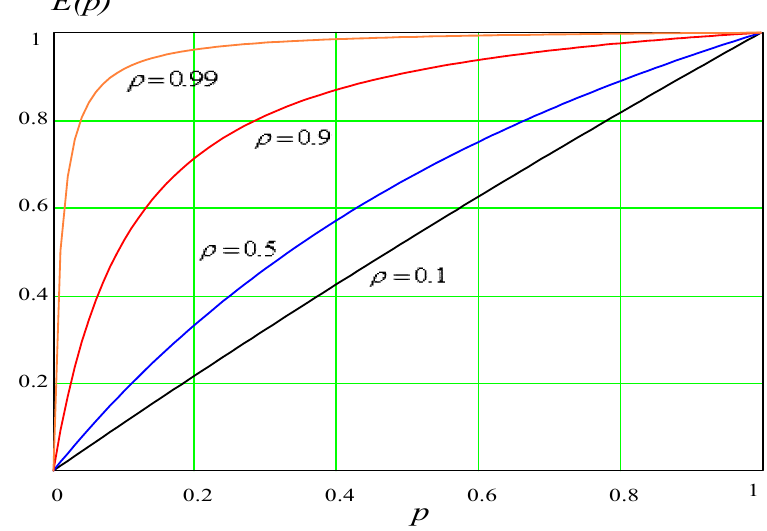
Figure 6. The traffic efficiency for the IoT based Fog system. Table 1. The experimental parameters and device specifications.